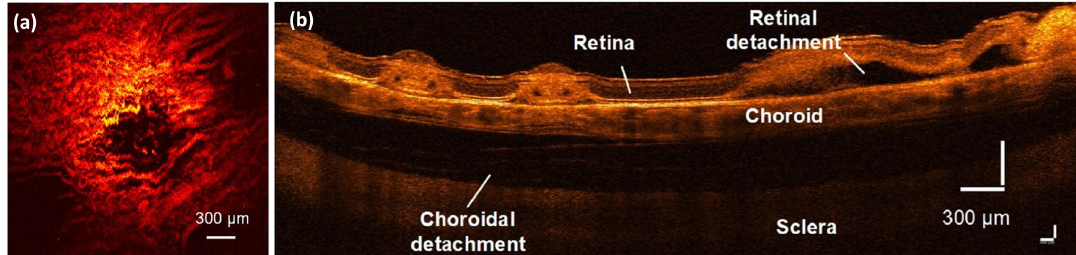
Figure 10. Multimodal photoacoustic microscopy (PAM), and optical coherence tomography (OCT) for chorioretinal imaging. ( a ) MIP PAM of laser-induced burn in choroidal vessels. ( b ) B-scan OCT image showing the location of laser treatment as well as retinal detachment [39]. Adapted with permission from ref. [39]